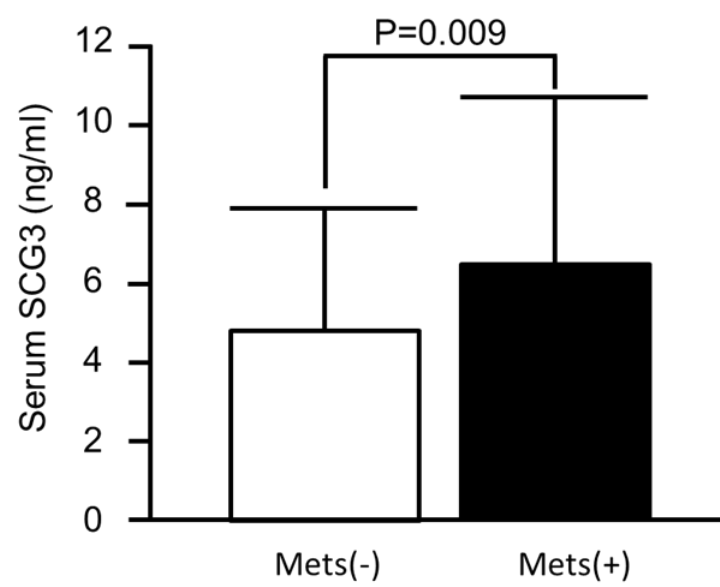
Figure 1. Comparison of serum secretogranin III levels between subjects without and those with metabolic syndrome (MetS).